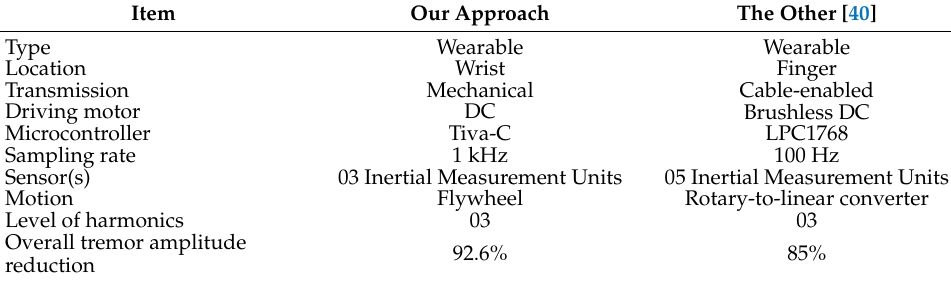
Table 3. List of technical specifications for comparative studies.